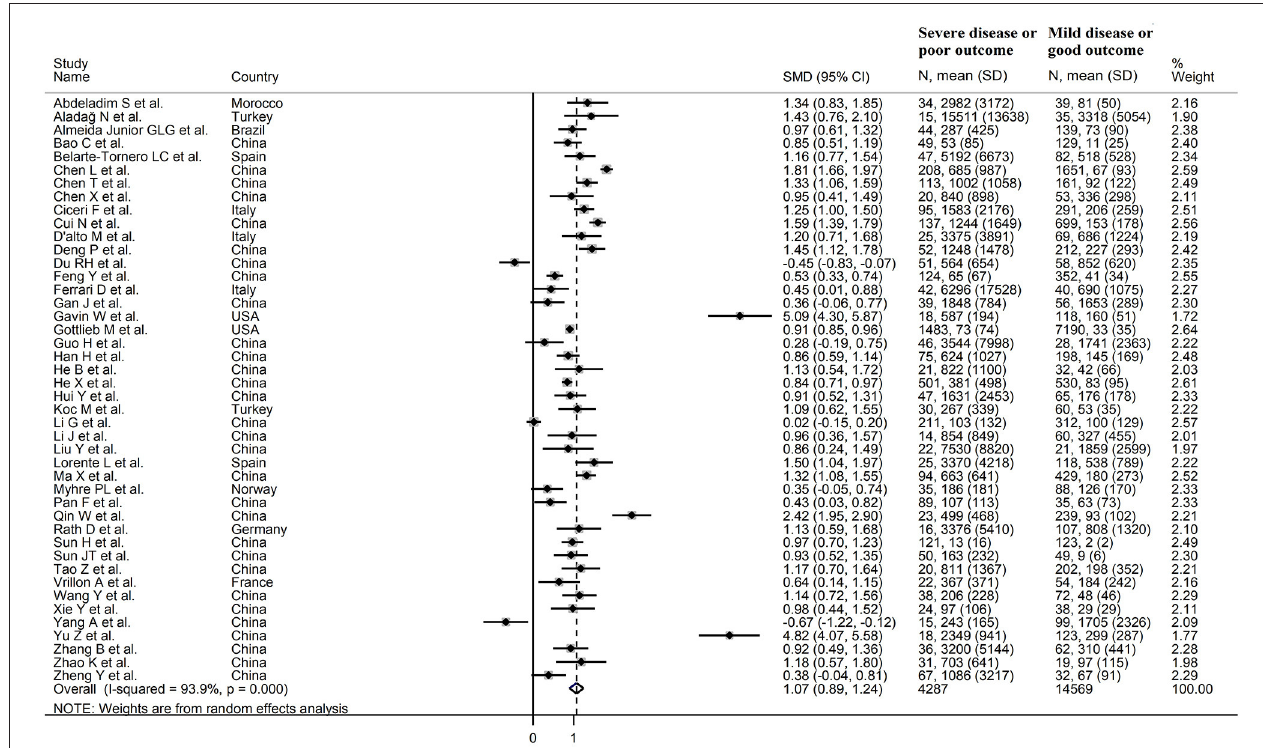
FIGURE 2 | Forest plot of studies reporting BNP concentrations in patients with